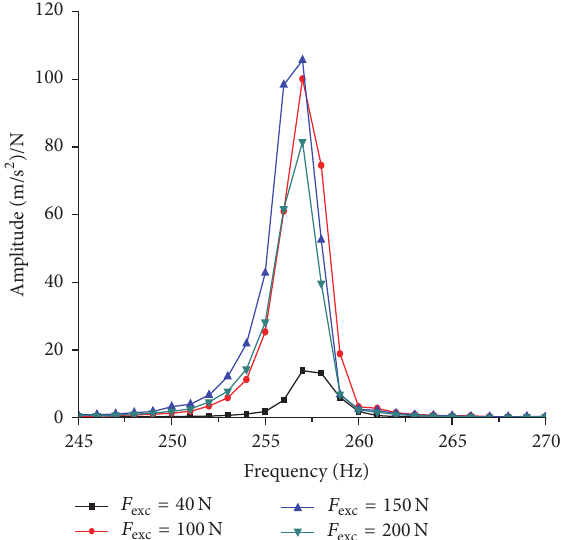
Figure 18: Frequency response functions of the second mode under different impact levels.